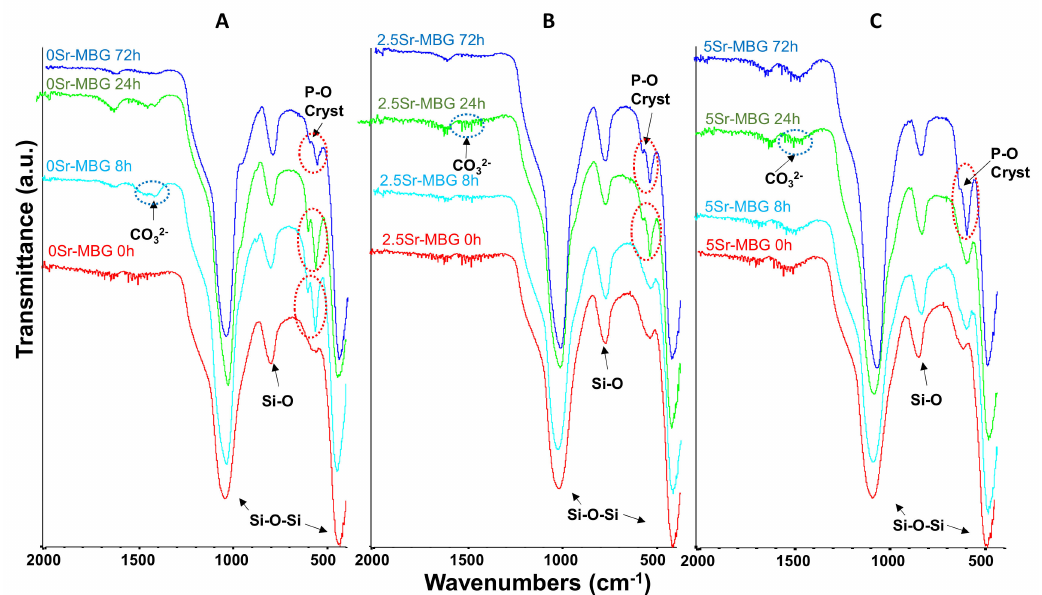
Figure 4. Fourier transformed infrared spectroscopy (FTIR) spectra of ( A ) 0Sr-MBG, ( B ) 2.5Sr-MBG and ( C ) 5Sr-MBG disks soaked in simulated body fluid (SBF) between 0 and 72 h. The red circles highlight the bands of crystalline phosphate and the blue circles highlight the bands of carbonate groups, both indicative of the nanometric carbonate hydroxyapatite formation. ( A – C